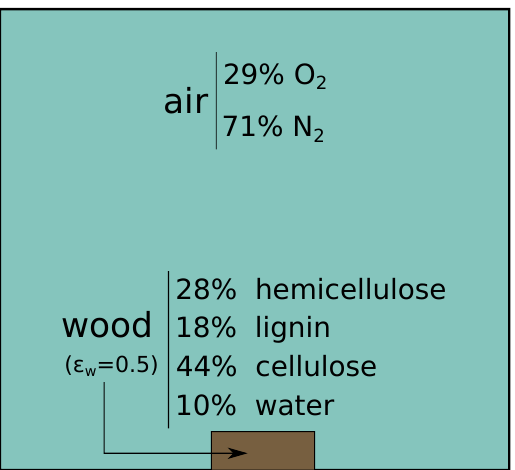
Figure 6. Numerical domain for the simulation of the burning of a wood log. A generic hardwood composition has been considered for the log. Air, with simplified composition, has been taken as